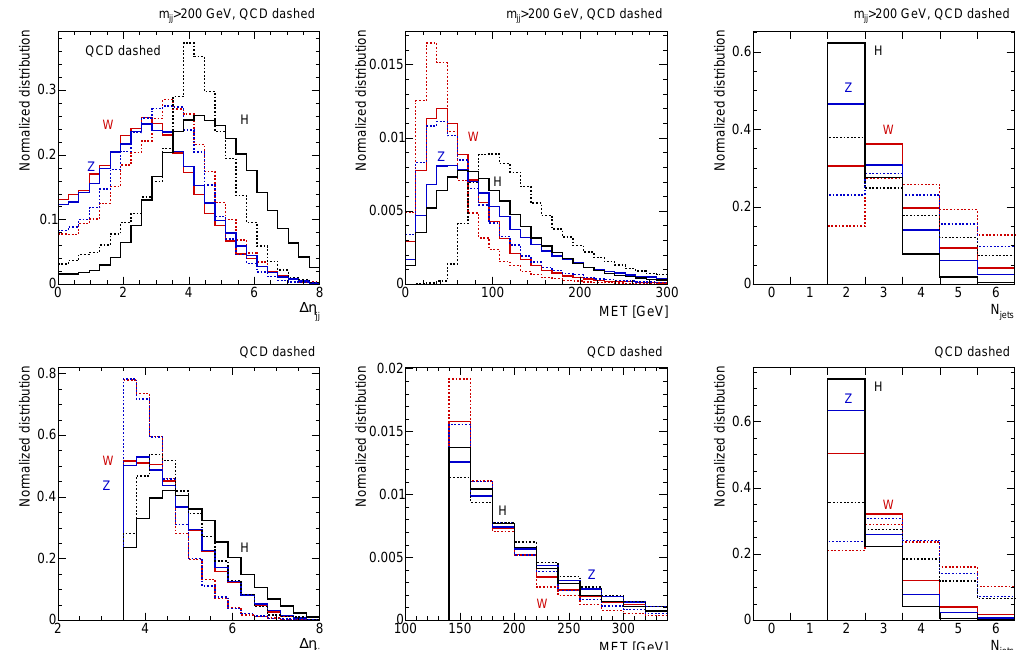
Figure 1: WBF signal and background distributions after the minimal requirement > 200 GeV (upper panels) and after the pre-selection cuts of Eq.(3). The ∆ η m jj (left) distribution for the V + jets Z backgrounds look very similar. Deviations be- tween W and Z backgrounds appear for the missing energy distribution (center) and N jets